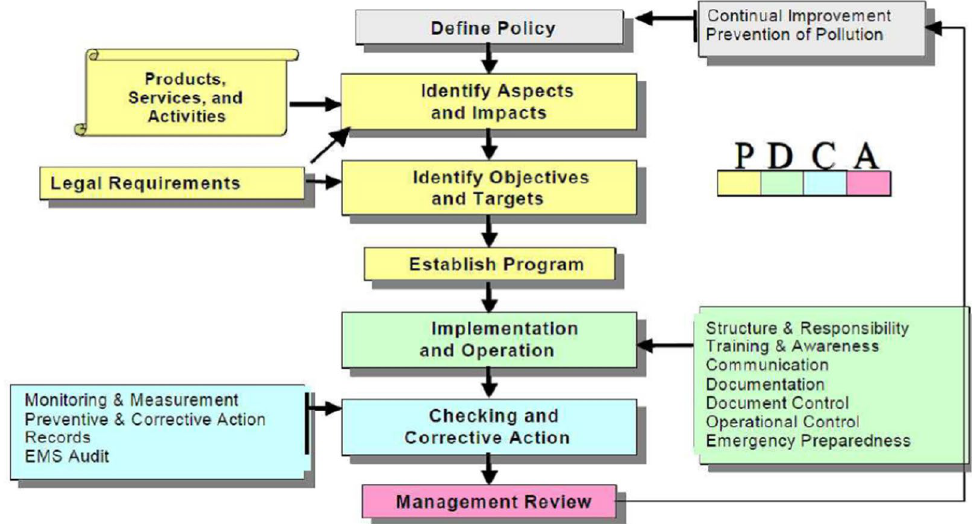
Fig. 5: PDCA cycle of the US Army EMS (Source: US Army-Environmental Center, 2005)